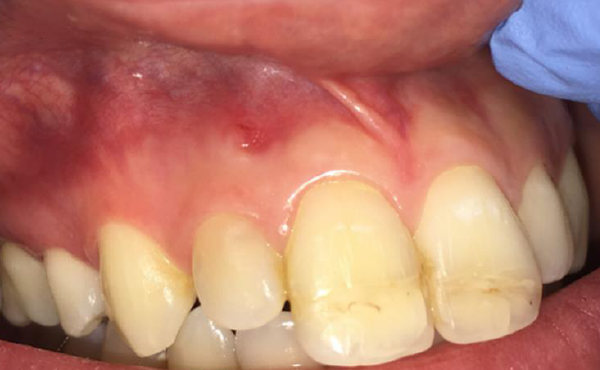
Figure 1. Clinical examination showing coronal integrity of tooth 1.2, discoloration of teeth 1.1 and 2.1, and the stoma of a sinus tract located apically between teeth 1.1 and 1.2.